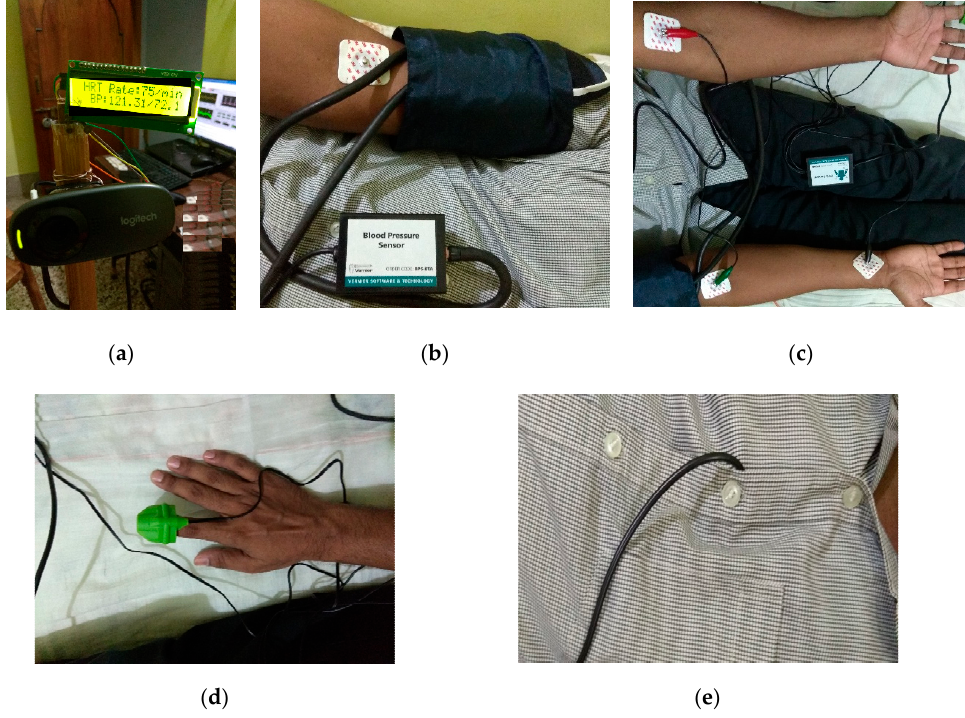
Figure 5. Sensors: ( a ) webcam and the 16 × 2 LCD arrangement; ( b ) blood pressure sensor; ( c ) ECG electrodes; ( d ) PPG and oximeter sensor; ( e ) thermistor temperature sensor probe.